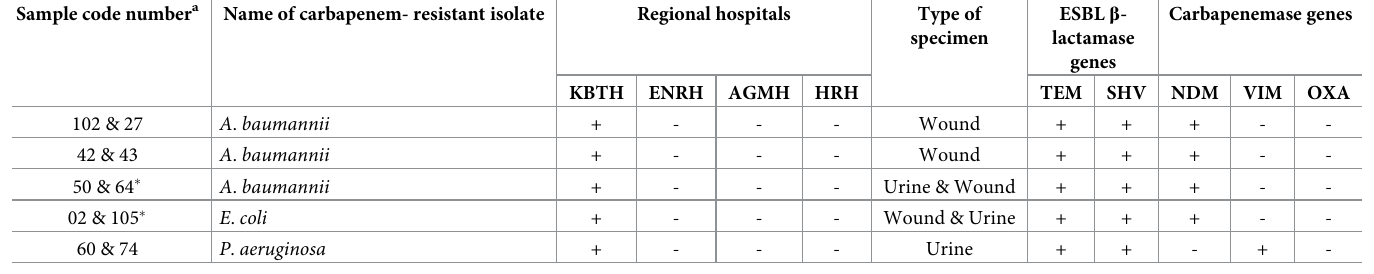
Fig 2. Dendrogram generated from ERIC-PCR genomic DNA products for carbapenemase-positive gene carriers. Key: isolate number or control strain/ type number. Regarding the groupings based on type of species, type of resistance gene, hospital location and source of specimen, the following groupings based on type of species: Group A ( A . baumannii NDM-1 positive) 102 & 27, 42 & 43 and 50 & 44 in urine and wound respectively; Group B ( E . coli NDM-1 positive) 02 & 105 in wound and urine respectively; Group C ( P . aeruginosa VIM-1 positive) 60 & 74 are showing close relatedness in cluster-pairs.